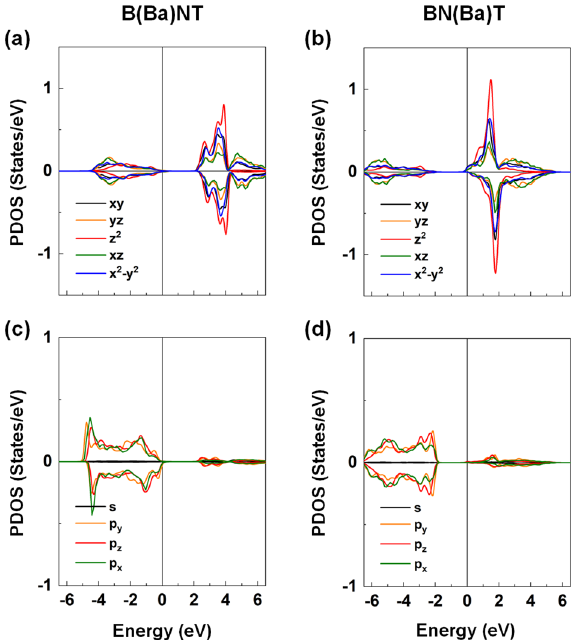
Figure 13. The DFT results of PDOS of the Ti and O atoms for (a) and (c) (Ba)NT and (b) and (d) BN(Ba)T at 3.33 at./% Ba doping. The Fermi level is set to zero energy.